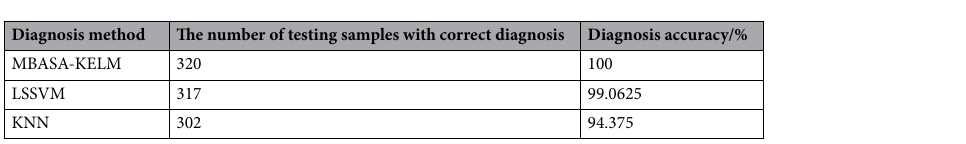
Table 1. The comparison of the diagnosis accuracies of bearing among MBASA-KELM, LSSVM, and KNN.